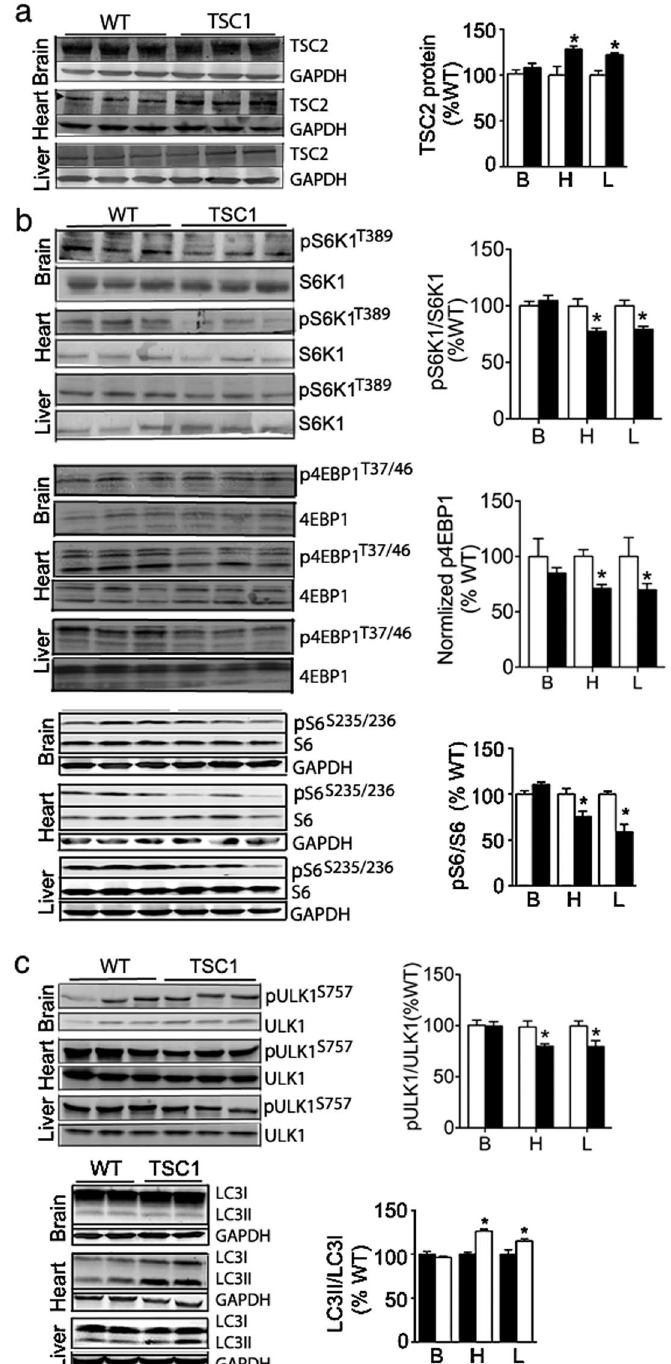
Figure 3. Effects of TSC1 overexpression on cell signaling. Proteins extracted from different tissues were subjected to western blot analysis as described in the methods section (n > = 6 mice at 4–6 month of age for each genotype, includes both male and female mice). ( a ) TSC2 protein expression in different tissues. ( b ) mTOR signaling was monitored as the level of phosphorylation of S6K1 (threonine 389), ULK1 (serine 757), 4EBP1 (threonine 37/46), and S6 (serine 235/236). ( c ) The detection of autophagy related changes: Phosphorylation of ULK1 (serine 757) and the conversion of an autophagy marker LC3 from LC3I to LC3II (LC3II/LC3I ratio). WT – wild type littermates; TSC1 - Tsc1 tg mice. B – brain; L – liver; H – heart. The band intensity was normalized to wild type mice in each group. The asterisks indicate statistical significance between Tsc1 tg and wild type mice in a specific tissue ( * p <